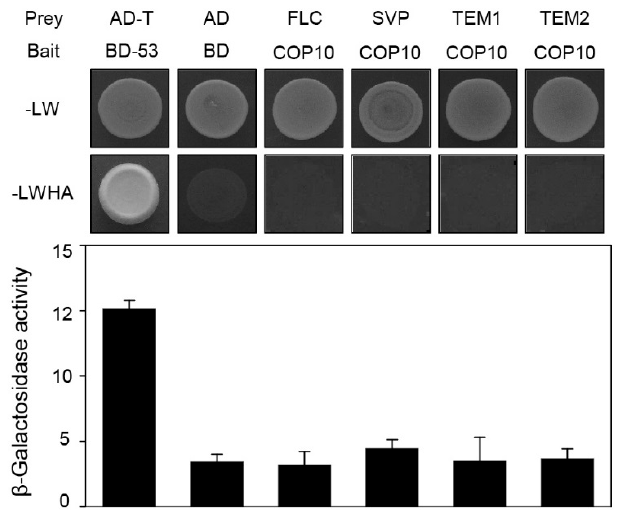
Figure 5. COP10 does not interact with FT repressors in yeast. The bait was full-length COP10. For prey, FLC, SVP, TEM1, and TEM2 were used. pGBKT7-53 (BD-53) and pGADT7-T were used as a positive control. Empty pGBKT7 (BD) and pGADT7 (AD) vectors were the negative control. SD medium (-LWHA; lacking tryptophan, leucine, histidine, and adenine) was used to select for the interaction between bait and prey proteins. β -Galactosidase activity assays were performed according to the manufacturer’s protocol. Means and standard deviations were obtained from three individual colonies. These experiments were repeated twice with the same results.